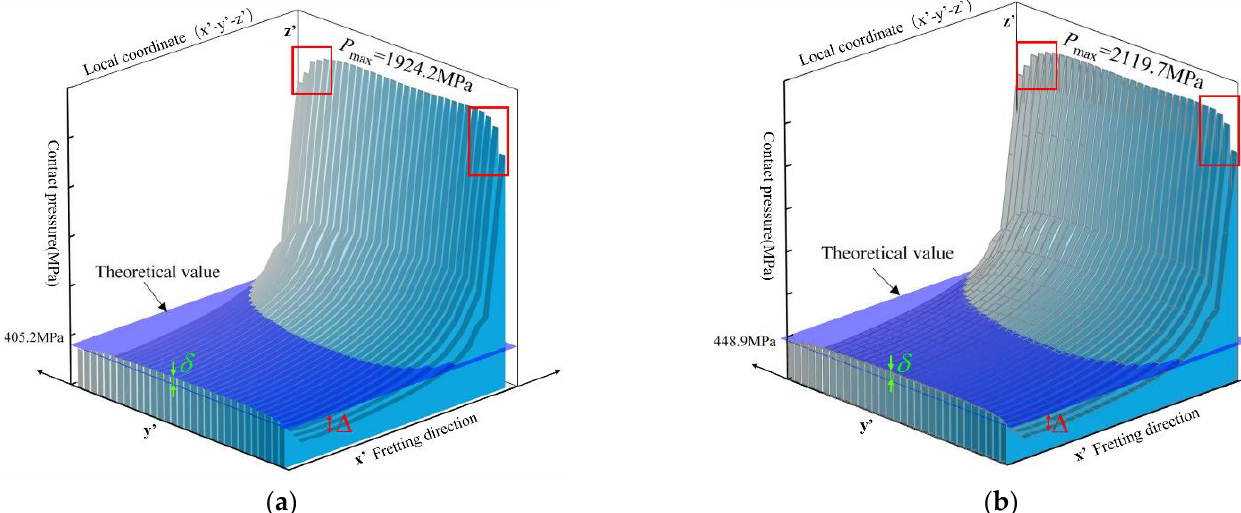
Figure 12. Distribution of the contact pressure on the contact surface for two fatigue load conditions. ( a ) 13,500N; ( b ) 16,451.6N.